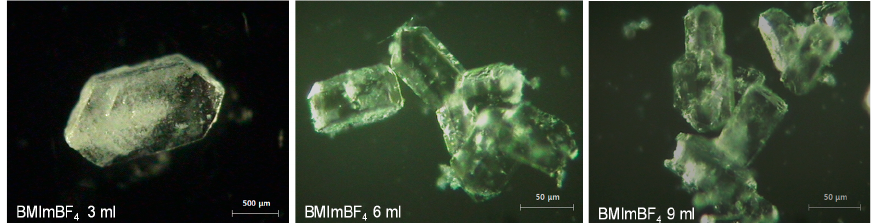
Figure 5. Video-microscope images of sucrose crystals obtained from the MeOH extraction solution of A. gigas (solvent volume of 3 mL) under BMImBF 4 anti-solvent concentration change using crystallization techniques.